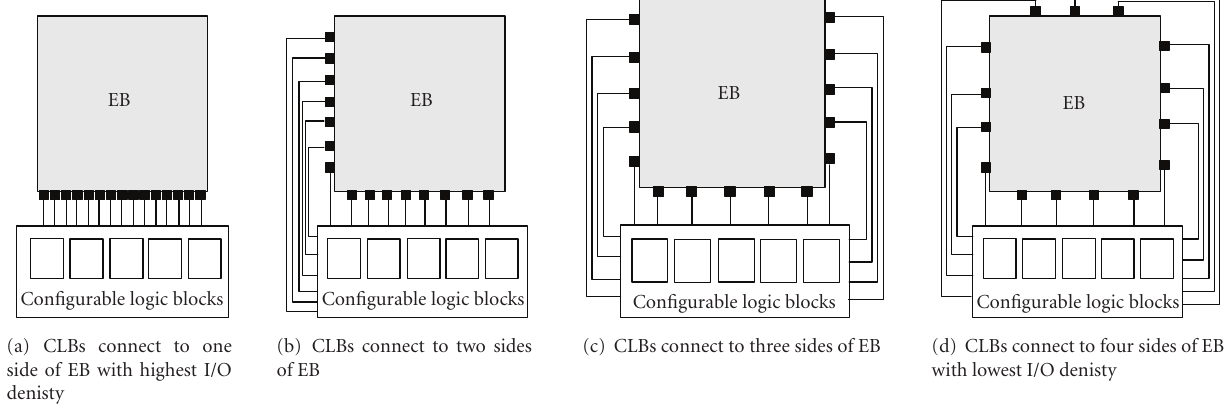
Figure 5: Di ff erent pin positions in EB.